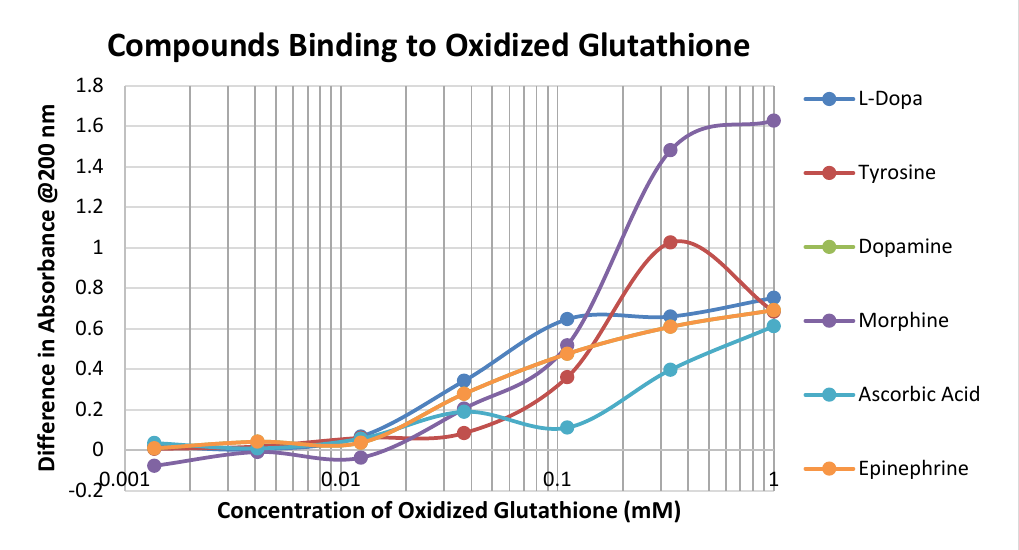
-0.200.20.40.60.811.21.41.61.8 Figure 3. Binding of diverse adrenergic and opioid compounds and ascorbic acid to oxidized glutathione. Comparison with Figure 2 demonstrates that binding affinities are generally lower to oxidized glutathione than to reduced glutathione (see Tables 1 and 2 for additional comparisons). bind ascorbic acid (Table 2). Figure 4. Binding of various adrenergic compounds and controls to the glutathione-like peptide NCY derived from the beta 2 adrenergic receptor. See Table 2 for additional data. Table 3. Overall patterns of binding between classes of compounds and receptor types. ^ Kd < or = 60 µM but >15 µM/Kd < or = 15 µM. Classes of compounds that bound to a receptor type at both cutoff values are shown bolded on a medium gray background; classes of compounds that bound to a receptor type only between 16 and 60 µM are bolded on a light gray background, while those that met neither cutoff value are normal type on a white background.